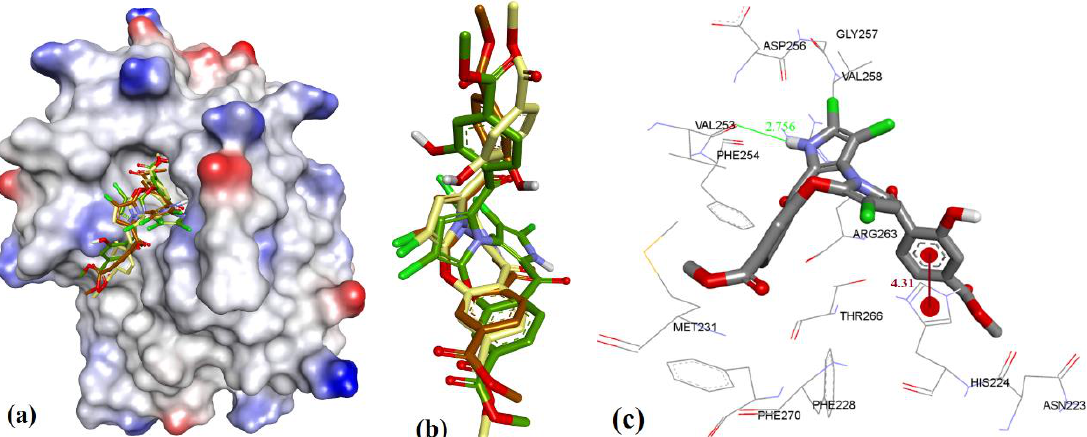
Figure 18. ( a ) The ionized solvent-exposed surface mapping of hMcl-1 along with the docked poses of cyclic marinopyrrole ( 5b ) from MOE (in brown), AutoDock (in green), and VlifeDock (in yellow) show their fitting to the cavity. ( b ) Similar-pose ensemble clustering of all three poses was attained from the three different docking methods. ( c ) Binding mode of cyclic marinopyrrole ( 5b ).